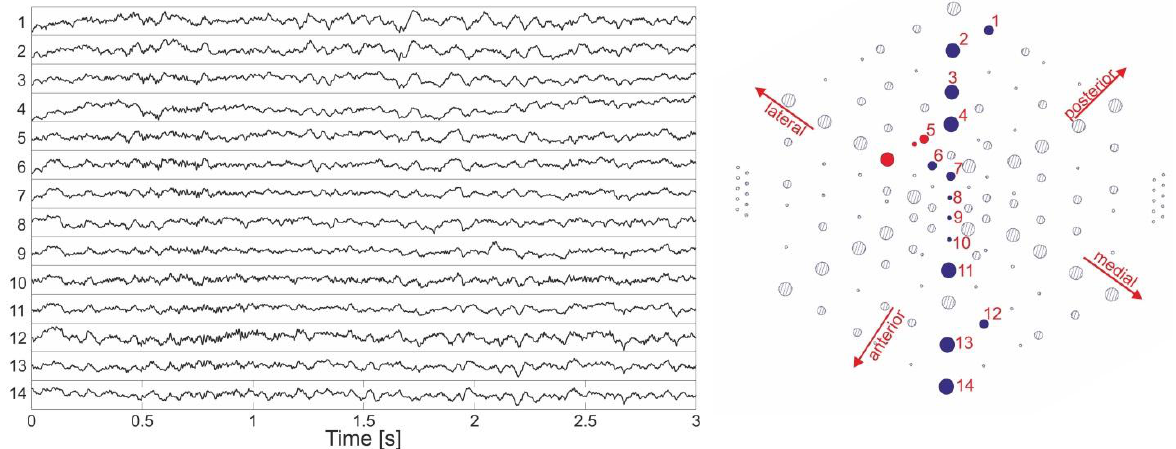
Figure 15. Electrophysiological signals (left image) recorded from electrode sites distributed over the array diameter (right image,